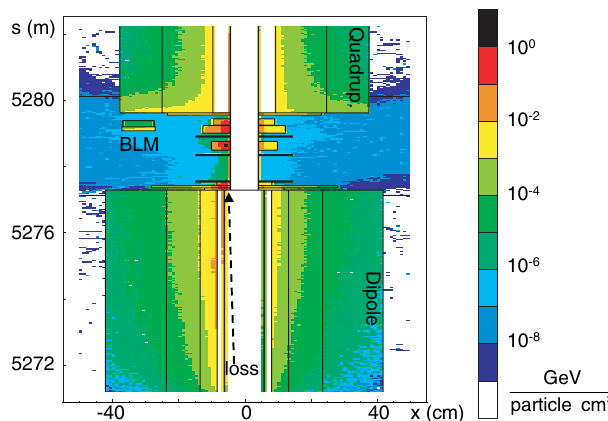
FIG. 11. (Color) The geometry as implemented in FLUKA around the monitor BL521 with the simulated energy deposition from a typical loss superimposed. The loss is indicated by the dashed arrow.